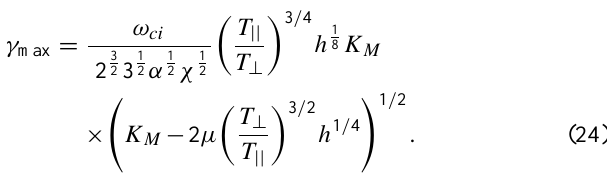
Fig. 1. Velocity distribution function F as the function of the wave amplitude h